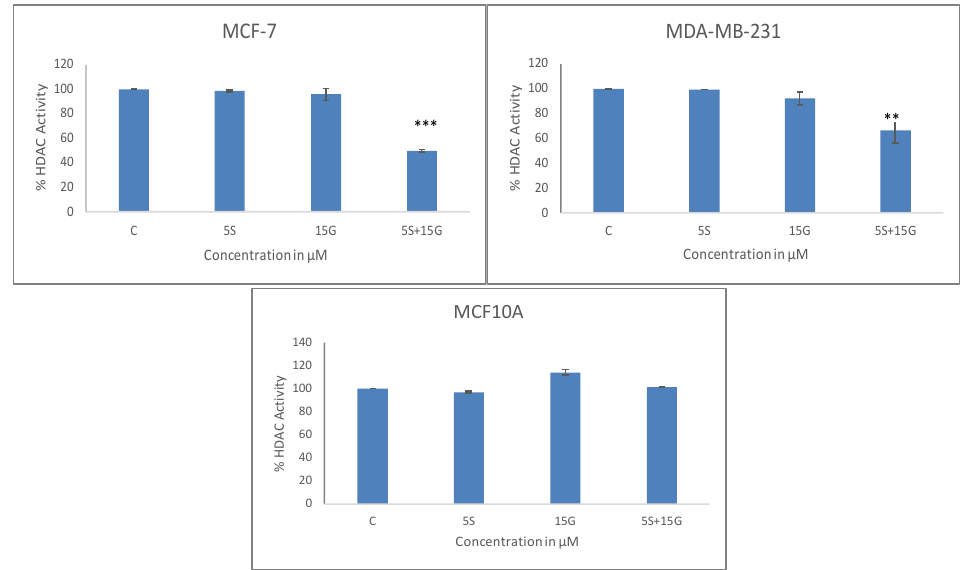
Figure 6. Histone deacetylase (HDAC) activity assay. HDAC enzymatic activity in breast cancer cells is downregulated by the combinatorial regimen. GEN and SFN downregulate HDAC activity in MCF-7 cells with the combination being the most effective. Combinatorial GEN and SFN downregulates HDAC activity in MDA-MB-231 cells with the combination being the most effective (** p < 0.01, *** p < 0.001). Combinatorial GEN and SFN does not significantly downregulate HDAC activity in MCF10A non-cancerous cells. Data are presented as mean ± SD.